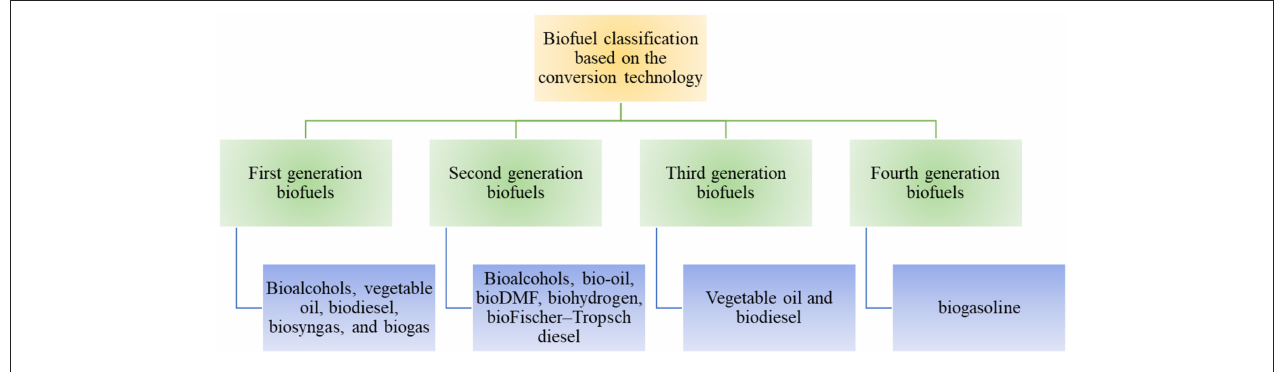
FIGURE 11 | Classification of bio-fuels presented based on the conversion